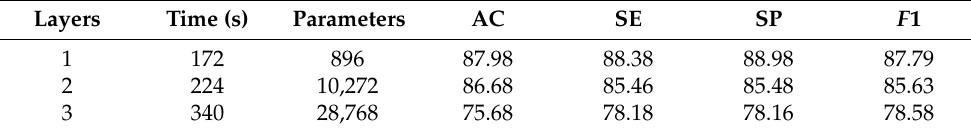
Table 3. Comparison of the classification results between difference CNN